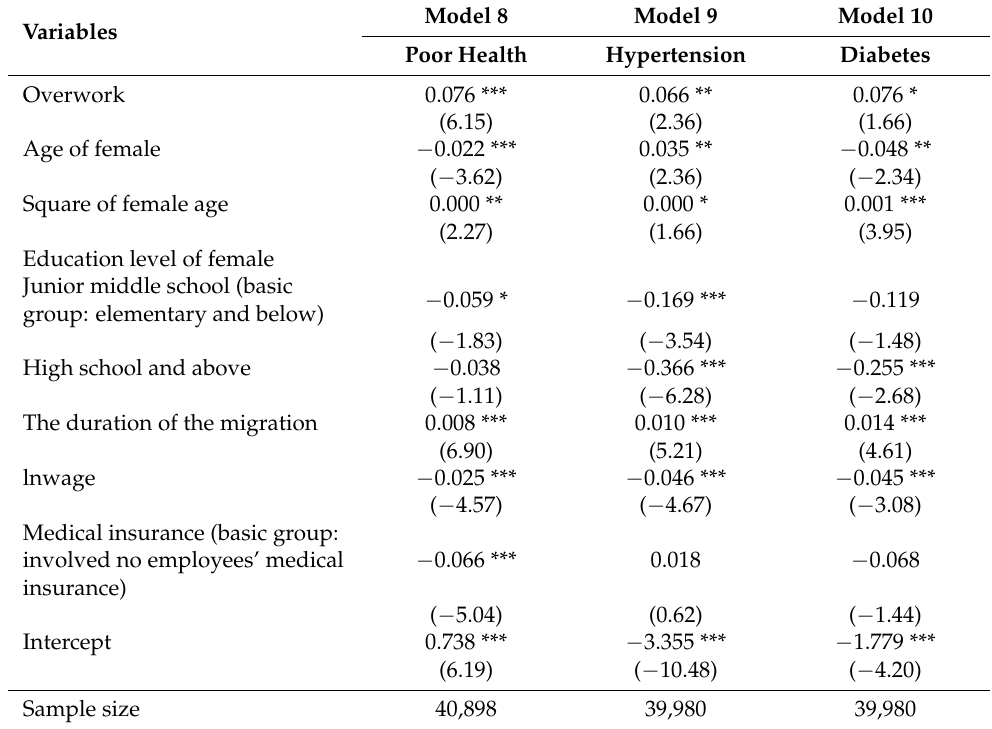
Table 4. Effects of overwork on migrant women’s